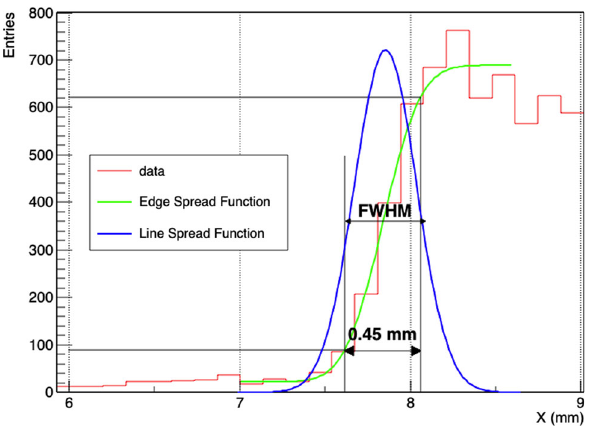
Fig. 13 TheedgespreadfunctionaswasobtainedfromX-raysstriking a MWPC